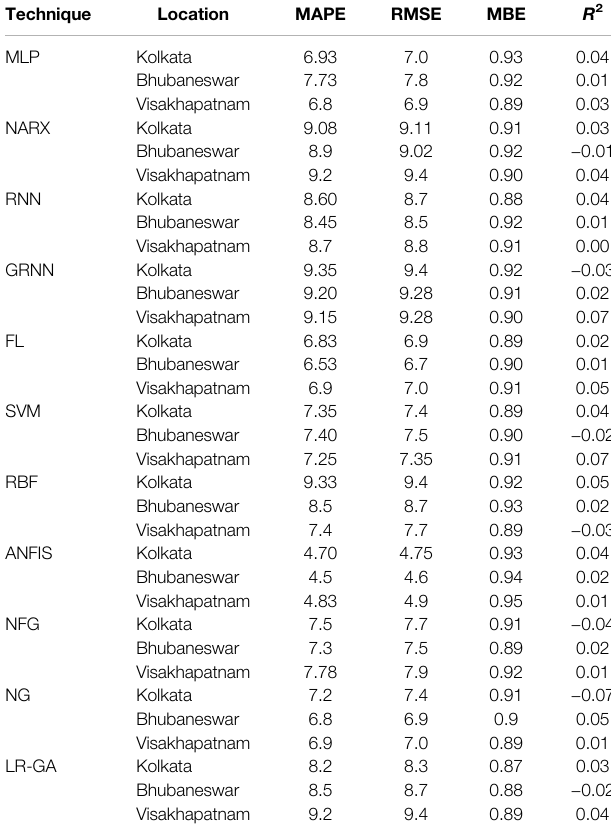
TABLE3| PerformanceevaluationofBhubaneswar,Kolkata,andVisakhapatnam with different algorithms. Technique Location MAPE RMSE MBE R 2